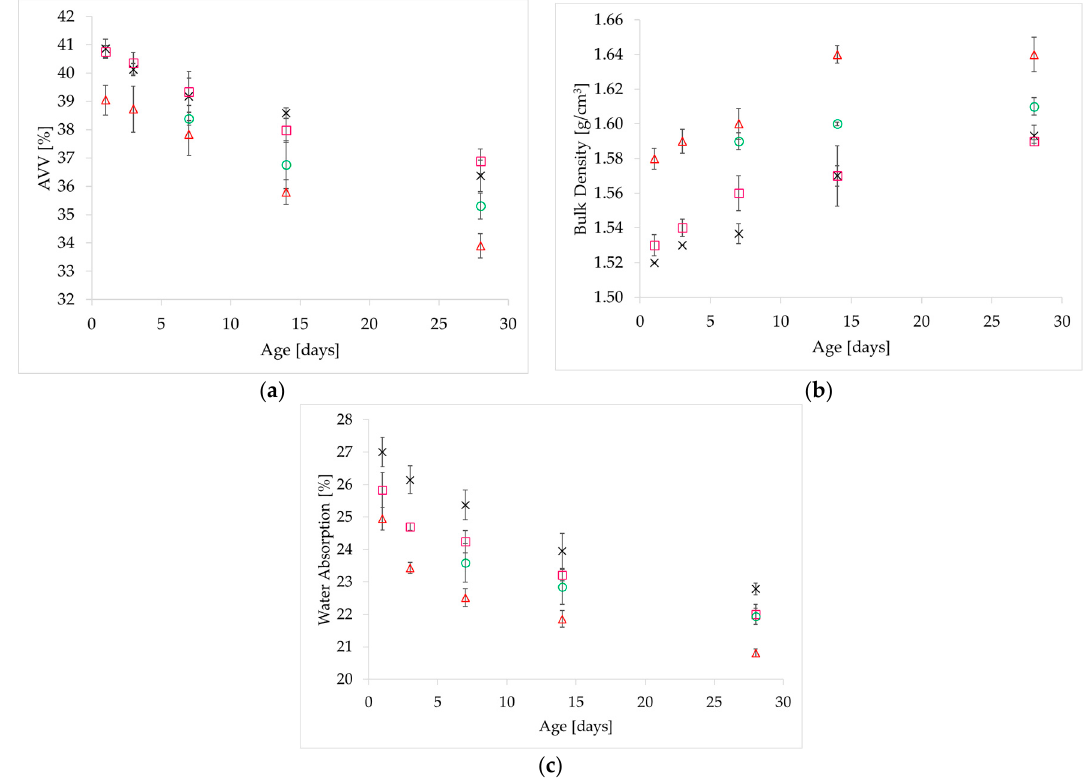
Figure 4. Average values of physical properties with different carbonation time (× NCC, □ 3 h ACC, ● 5 h ACC and ∆ 9 h ACC): ( a ) Apparent void volume (AVV); ( b ) bulk density (BD) and ( c ) water absorption (WA).